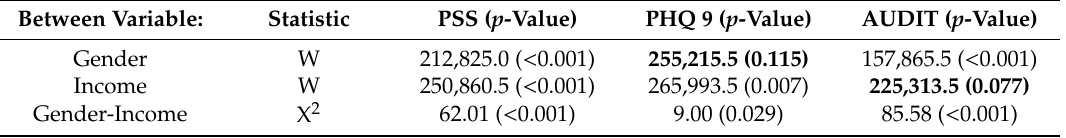
Table 4. Gender and income di ff erences in PSS, PHQ 9, and